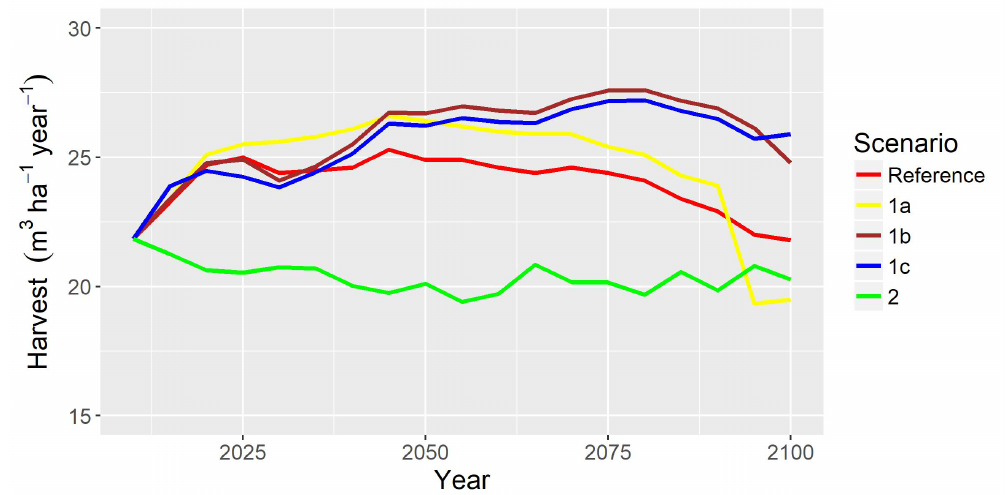
Figure 1. Harvested stem volume including bark in different forest management